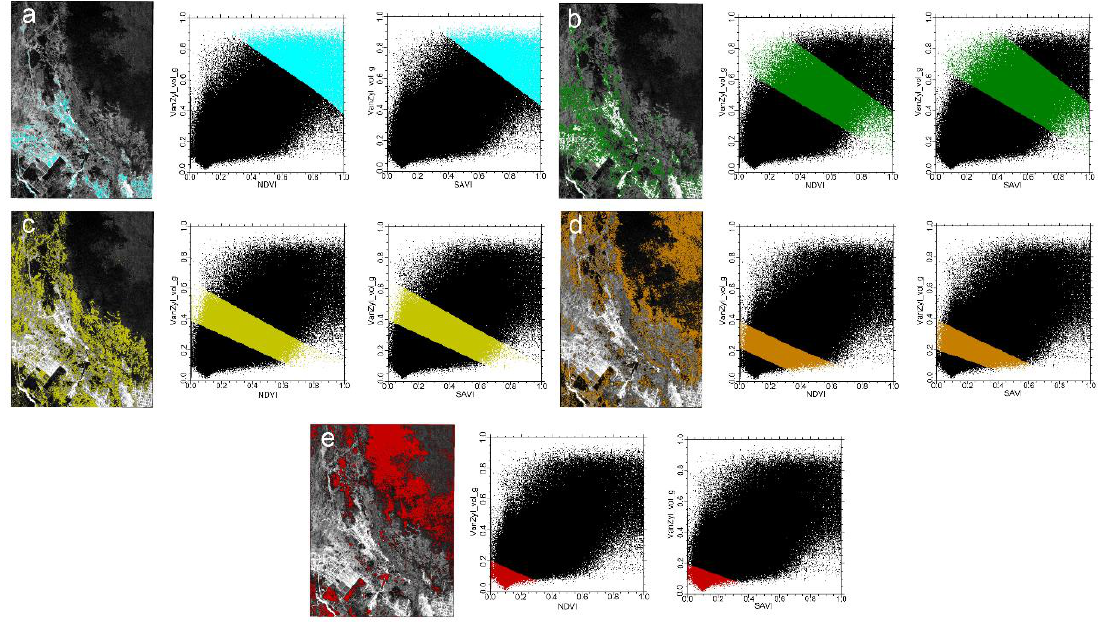
Figure 8. The soil salinity content in the images and NDVI-Van_vol_g and SAVI-Van_vol_g spaces: ( a ) water; ( b ) plant cover; ( c ) mildly saline soil; ( d ) moderately saline soil; ( e ) heavily saline soil.